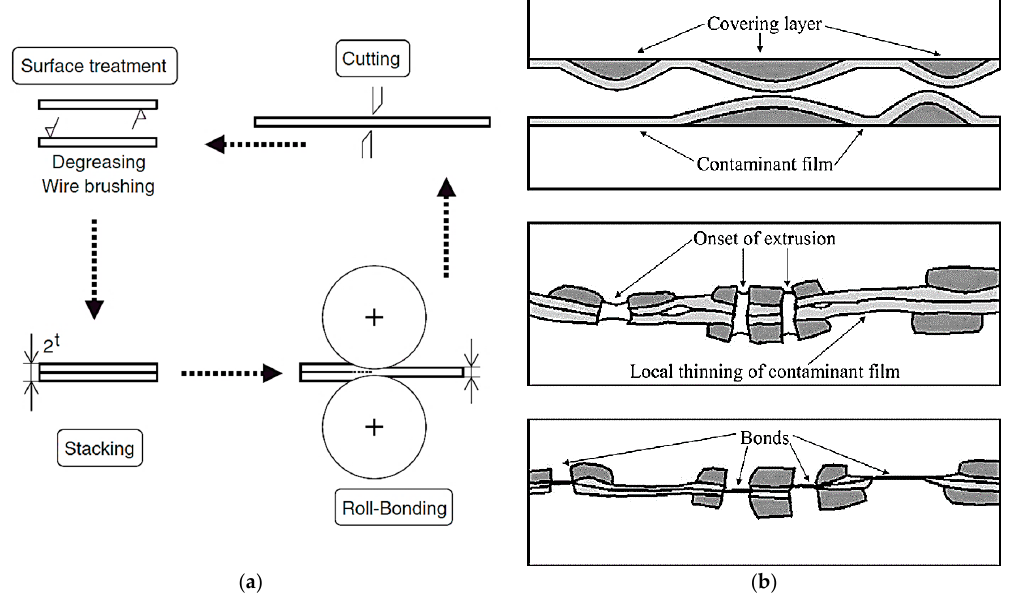
Figure 1. ( a ) Schematic illustration of principles of the accumulative roll bonding (ARB) process, ( b ) Schematic illustration of fracture and extrusion of surface layer during ARB.